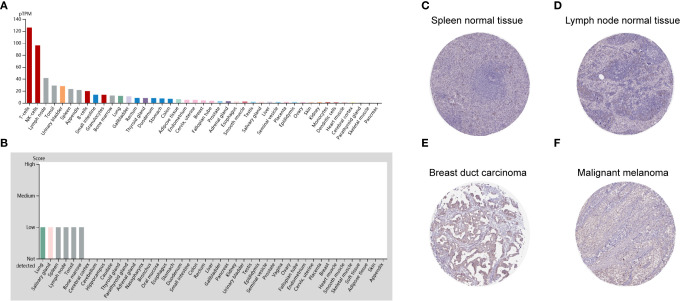
CD96 expression profiles in human normal and cancer tissues. (A) CD96 expression profiles in normal human tissues. (B) The protein expression profiles of CD96 in human normal tissues. (C–F) Representative IHC images of CD96 expression in normal lymph node tissues, normal spleen tissues, breast duct carcinoma tissues, and malignant melanoma tissues.